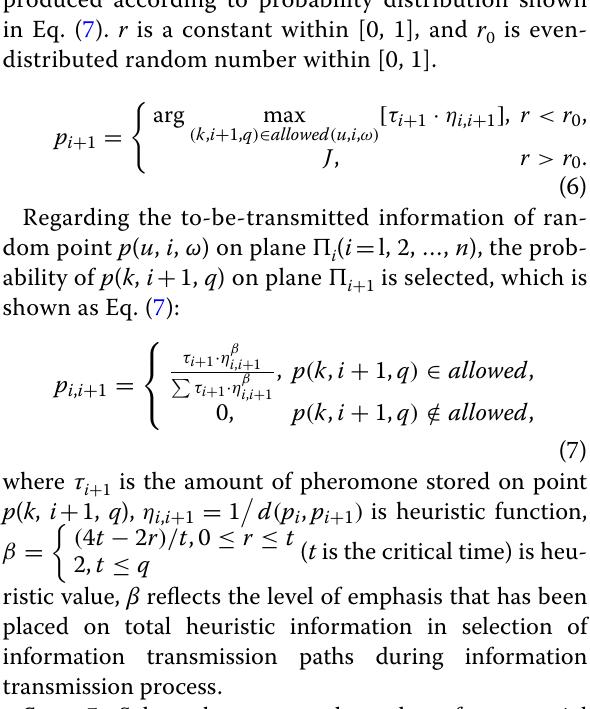
According to the operation flow of AC-GA-based 3D path optimization, and based on initial population established by genetic algorithm and collected node